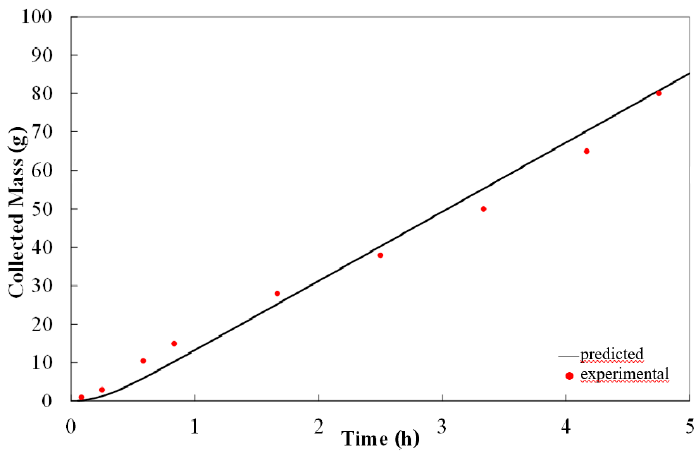
Figure 5. Collected mass versus time.